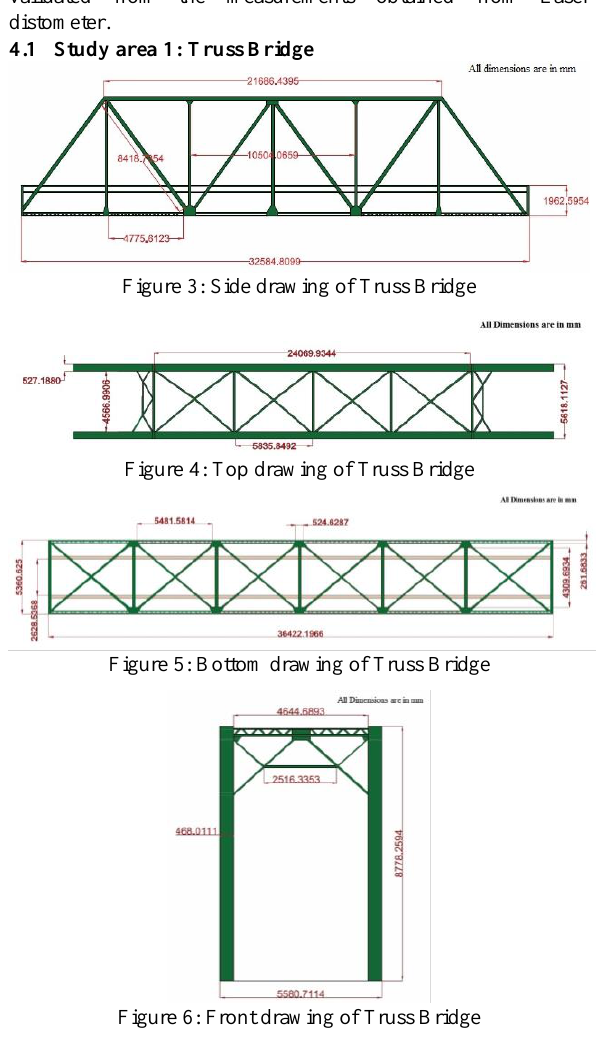
Figure 6: Front drawing of Truss Bridge